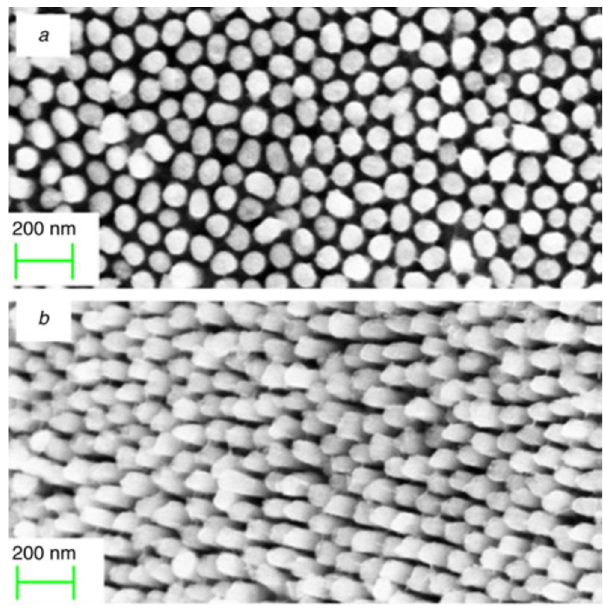
Figure 8. SEM micrographs of IrO 2 nanorods synthetized through the chemical bath route: ( a ) top view; ( b ) tilted view (Reprinted/adapted with permission from Ref. [107]).